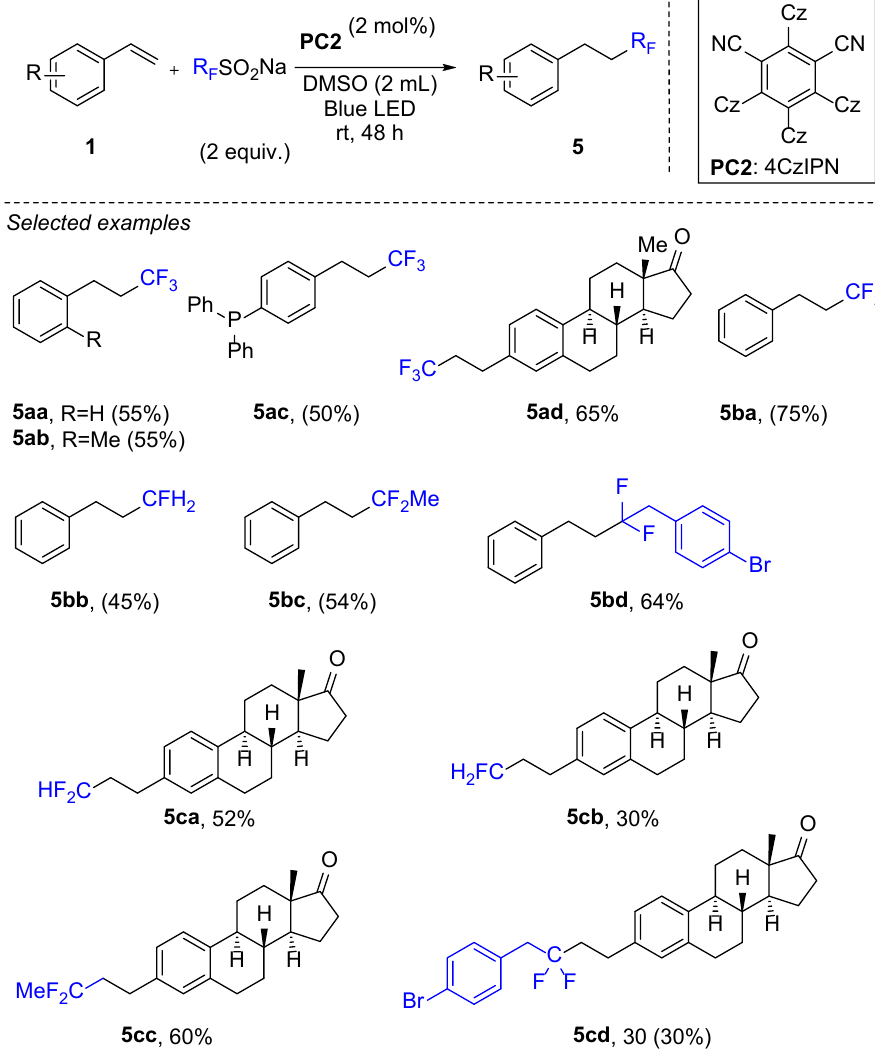
Figure 3. Hydrofluoroalkylation of styrenes developed by the group of Tlili. From a mechanistic standpoint, and in contrast to previously described methods, no additive was required. Mechanistic investigation including luminescence, EPR spectroscopy confirmed the SET oxidation of the Langlois reagent with the excited organophotocatalyst 4CzIPN. Afterwards, the formed trifluoromethyl radical collapses to the styrene to afford radical A that could be reduced with radical anion photocatalyst producing anion B and furnishing the organophocatalyst at its ground state. Finally, protonation of the formed anion allows the formation of the desired product. Herein, it should be mentioned that simply adding CO 2 allows the carboxylation of anion intermediate B . Moreover, adding deuterated water in the media allows the incorporation of the deuterium atom (Figure 4).